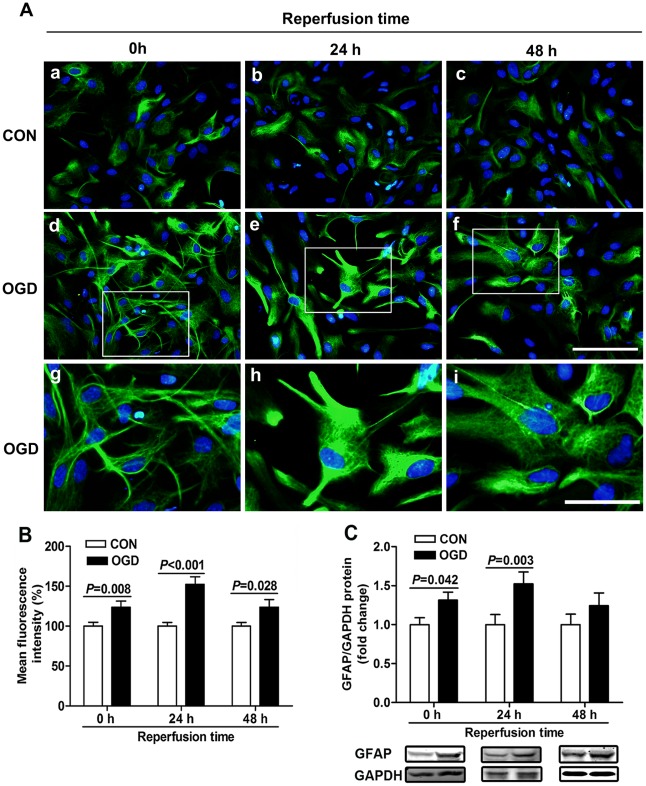
GFAP expression and proliferation of astrocytes were analyzed at various reperfusion times after 6 h OGD.(A) GFAP immunostaining (green) after OGD. Control astrocytes cultured for 0 (a), 24 (b) and 48 h (c) were flat and polygonal. Astrocytes treated with OGD became stellate and clustered, extended processes, and had high GFAP fluorescence intensity in stretched processes after 0 h reperfusion (d, box in d is enlarged in g). After 24 h reperfusion, astrocytes were hypertrophic, and GFAP staining intensity was upregulated in cell body and processes (e, box in e is enlarged in h). And after 48 h reperfusion, some astrocytes still had high GFAP fluorescence intensity in their cell body or processes (f, box in f is enlarged in i). Figures g, h and i were amplification of boxes in figures d, e and f, respectively. Scale bars = 100 µm for a-f; and scale bars = 50 µm for g-i. (B) Quantification of mean GFAP fluorescence intensity. (C) Western blot analysis of GFAP expression. Values are from 3 to 6 independent experiments.